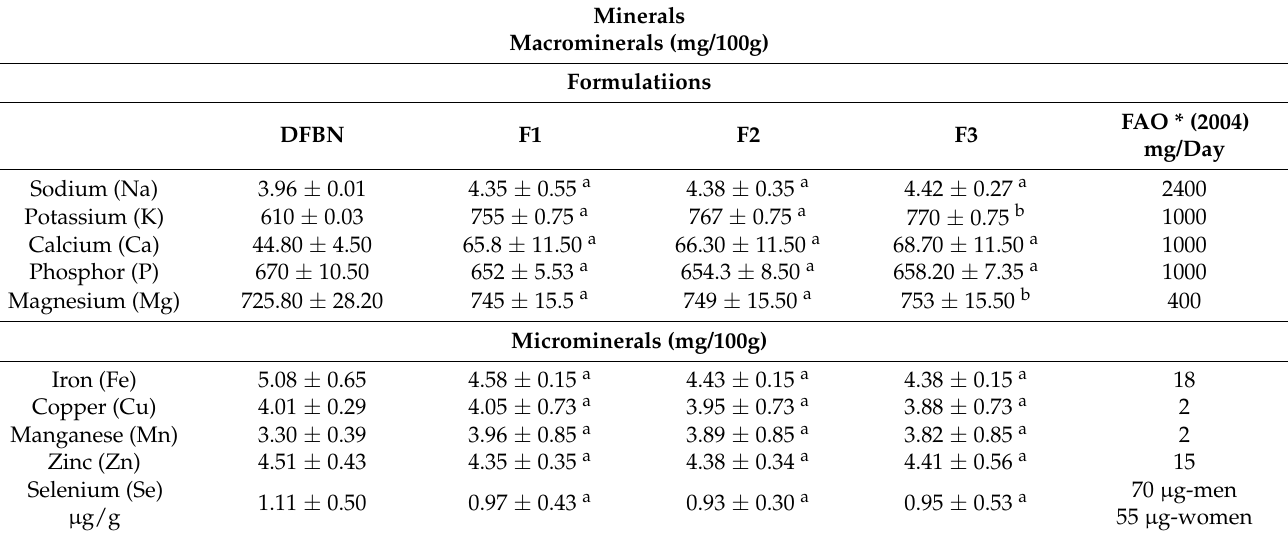
Table 3. Composition of macro and micro minerals in DFBN and the